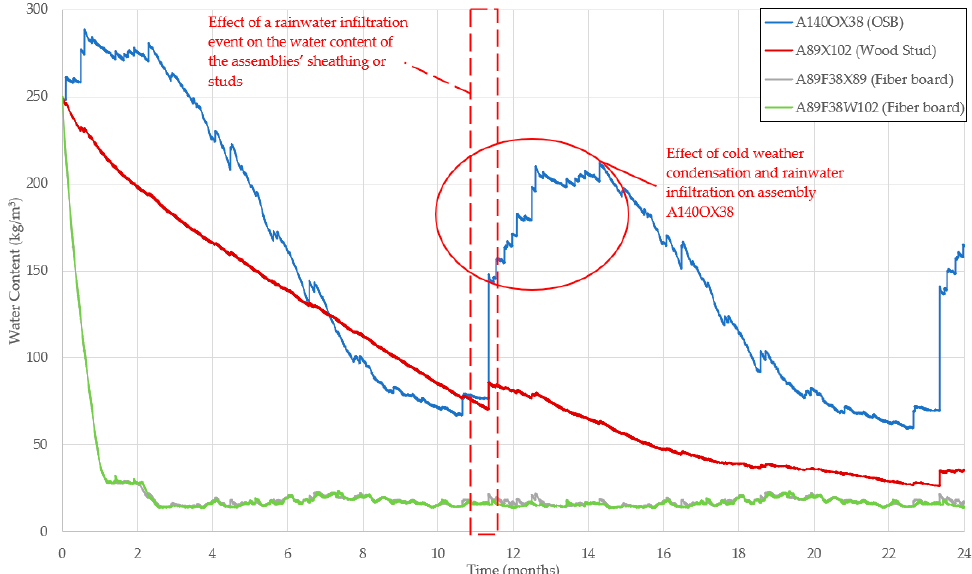
Figure 7. The sheathing or wood stud water contents for the full duration of the simulation under highly unfavorable exposure conditions in the cold climate.